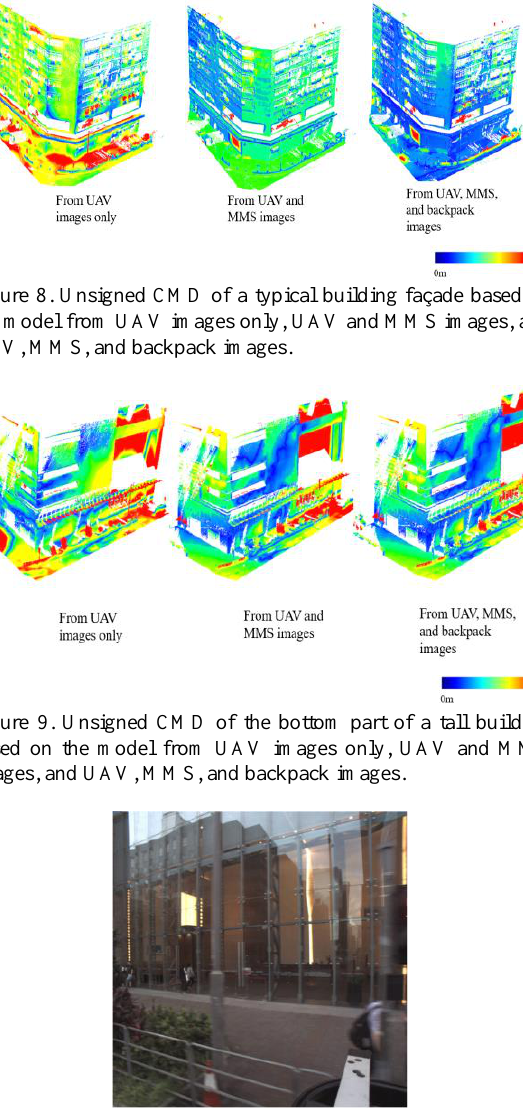
Figure 10. An example of a glassed façade.